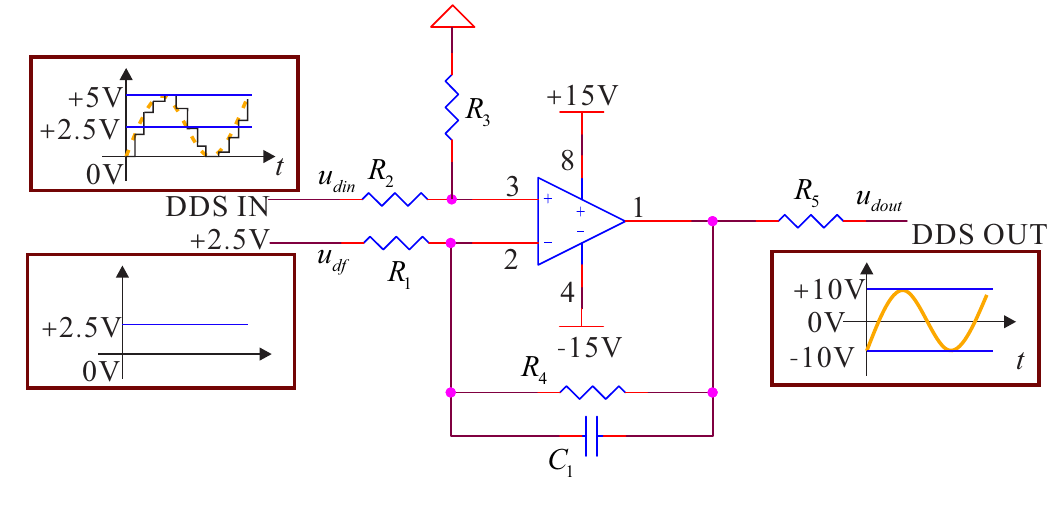
Figure 6. The signal conditioning system of the driving